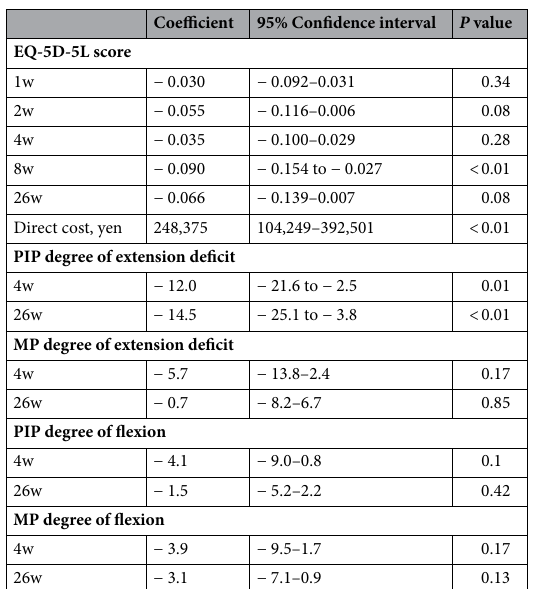
Table 3. Results of secondary outcomes after propensity-score adjusted generalized linear modeling between Collagenase and Surgery groups. Coefficients (and their 95% confidence intervals) indicate the degree of each outcome in the Surgery group with reference to the Collagenase group. w, week.